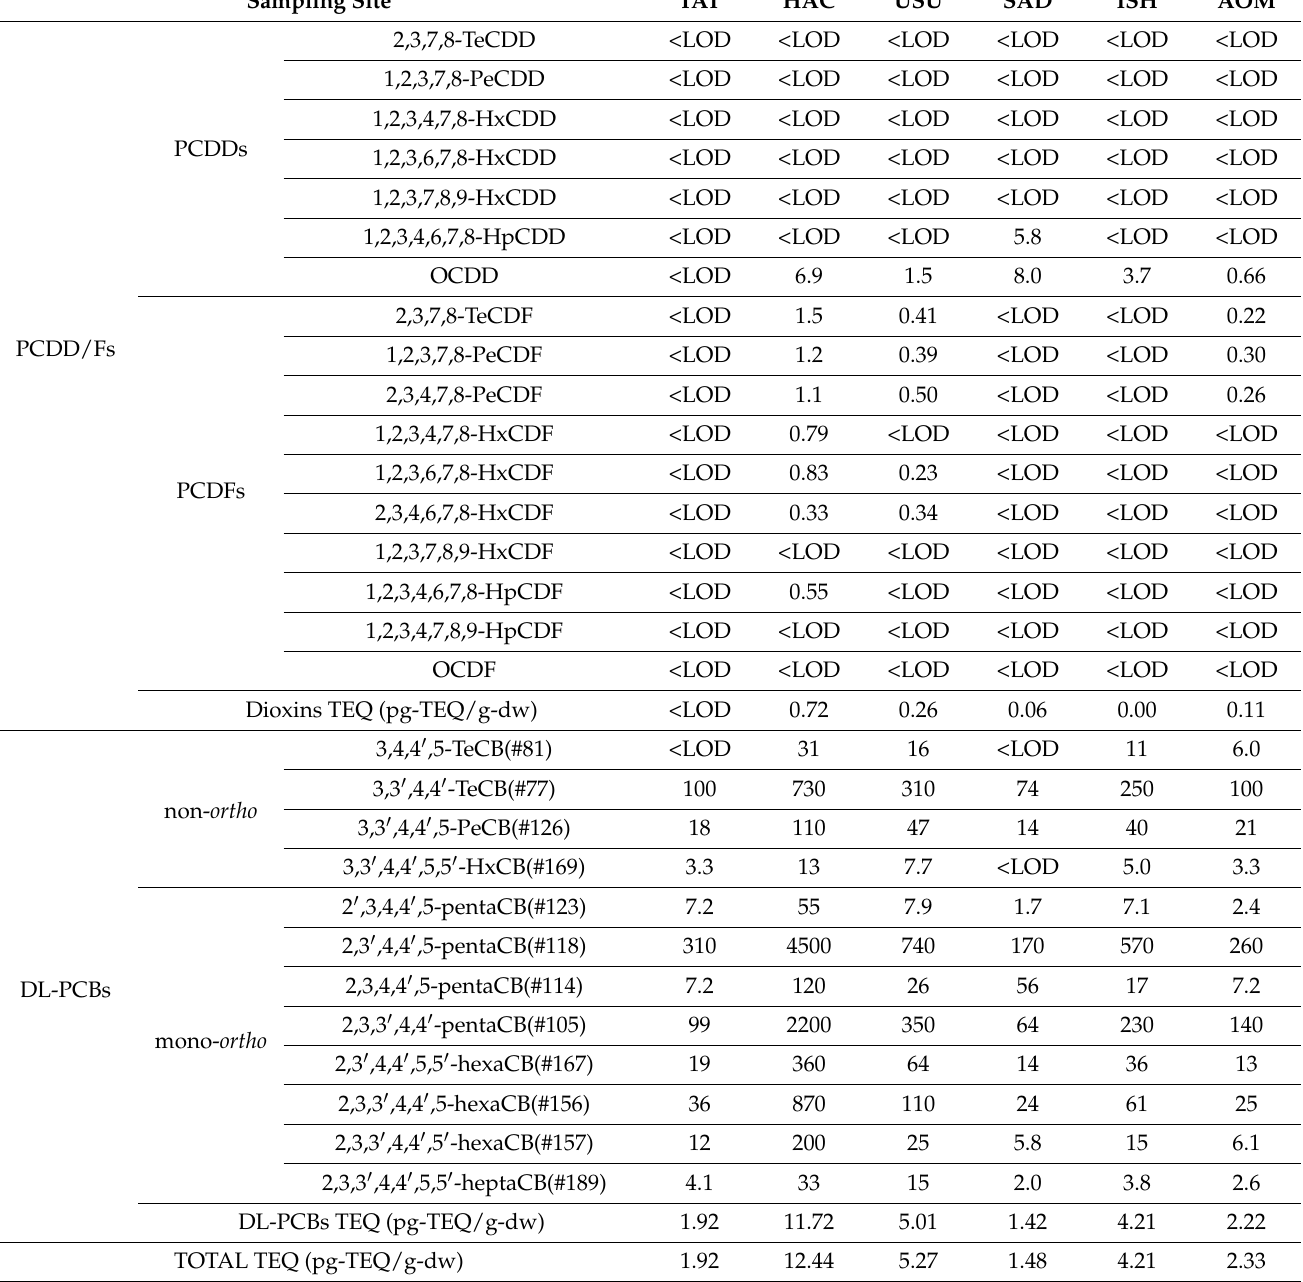
Table 2. Detected concentrations of individual PCDD/Fs and DL-PCBs (pg/g-dw) and total TEQ value (pg-TEQ/g-dw) in wharf roach collected from 11 sampling sites (sample from SAS, Miyagi, was not